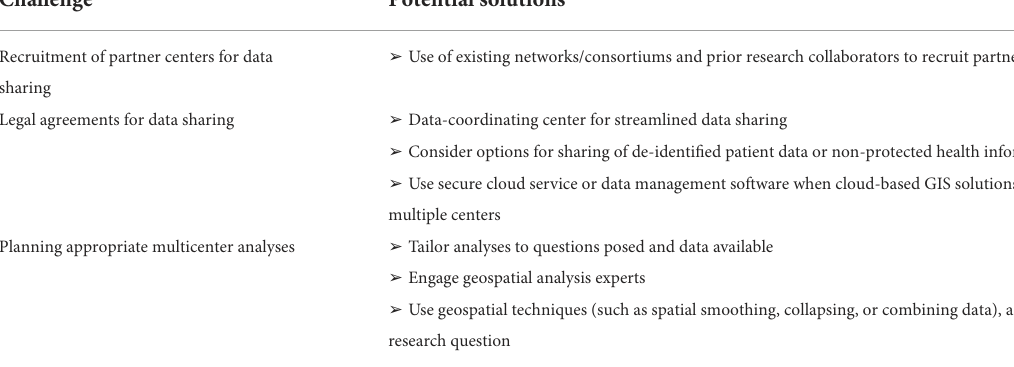
TABLE 1 Challenges and solutions to multicenter geospatial